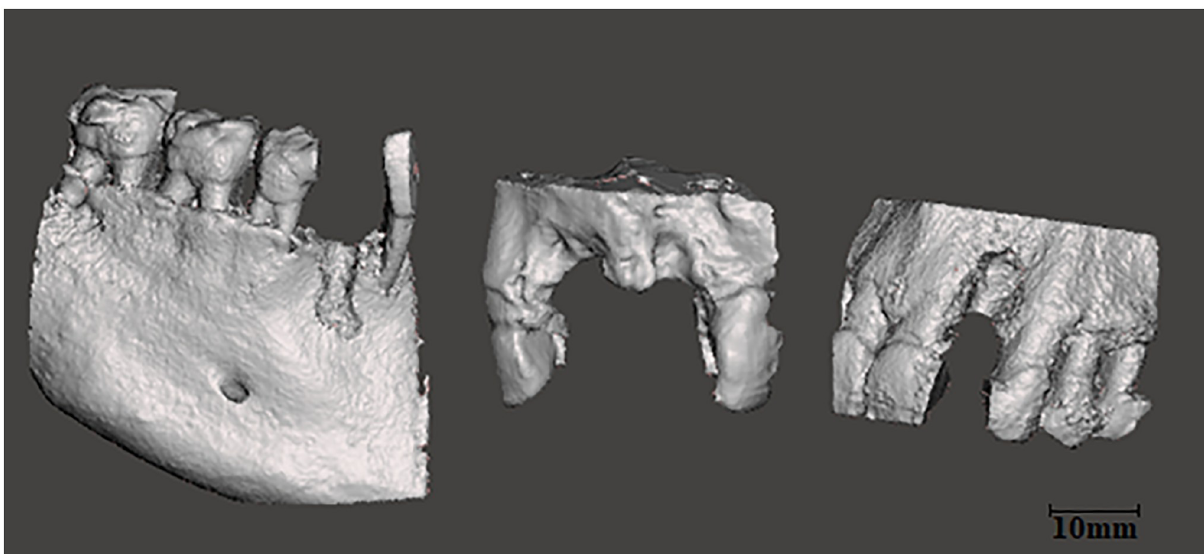
Fig 1. Group1: Representative lateral views of virtual 3D models with small-defects.